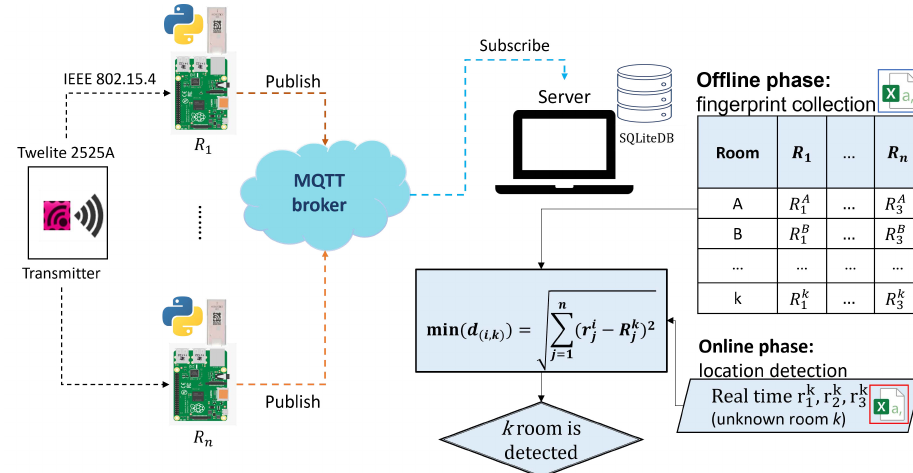
Figure 3. FILS15.4 application